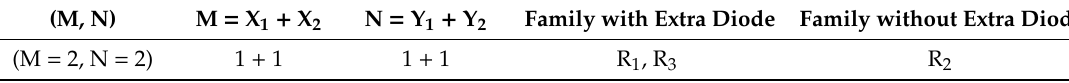
Table 1. Topological families under M = 2 and N = 2.